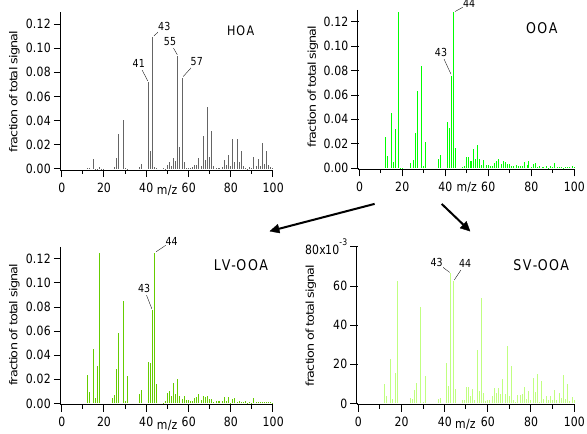
Fig. 1. Example mass spectra of the HOA, total OOA, LV-OOA and SV-OOA components identified from the Pittsburgh dataset (Zhang et al., 2007; Ulbrich et al., 2009). Note that the total OOA spectrum is not the average of the LV-OOA and SV-OOA because LV-OOA accounts for a much larger fraction (59%) of OA than SV-OOA (10%) in Pittsburgh.